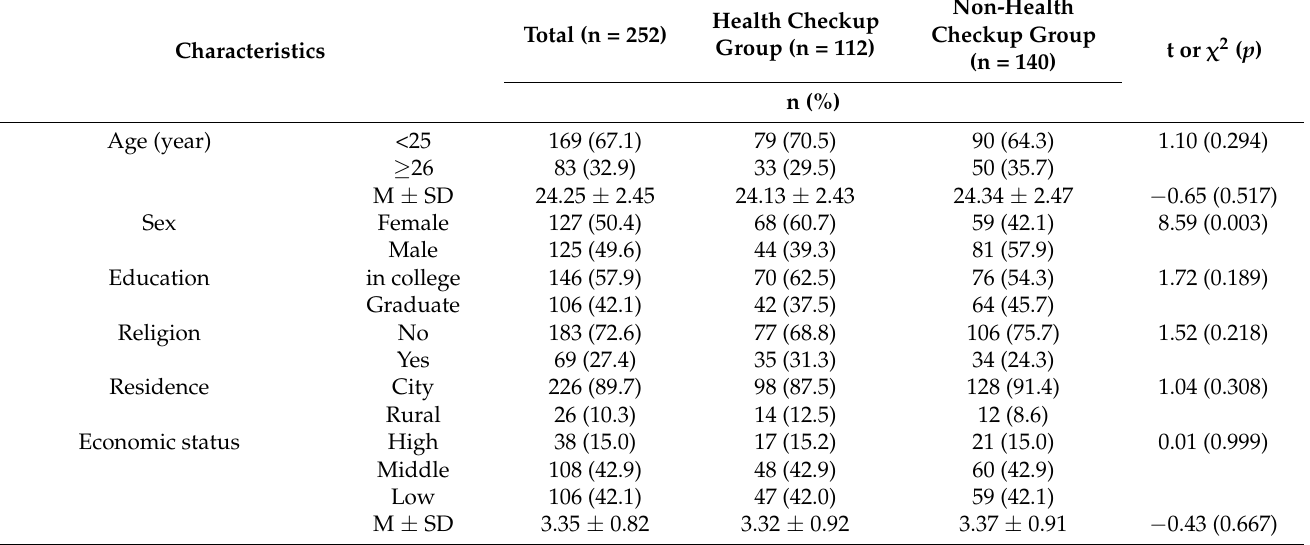
Table 1. Characteristics of the participants (n =